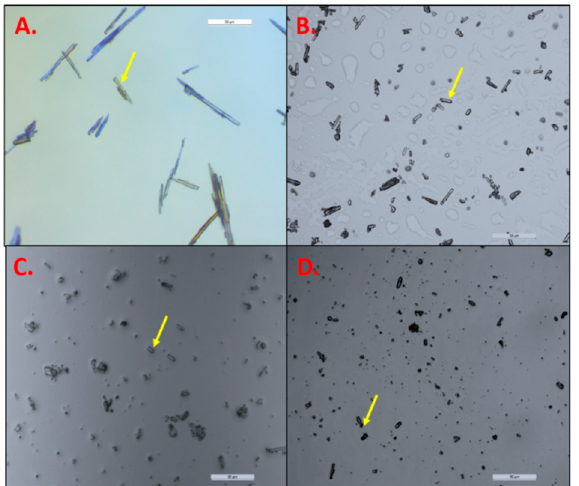
Figure 3. A . Microscopic images of pure TAF particles suspended in heptane; TAF particles in suspension formulation, before addition of adhesive (at 20×) after homogenization at: B . 30,000 rpm for 20 min; C . 32,000 rpm for 30 min; D . 32,000 rpm for 5 min.